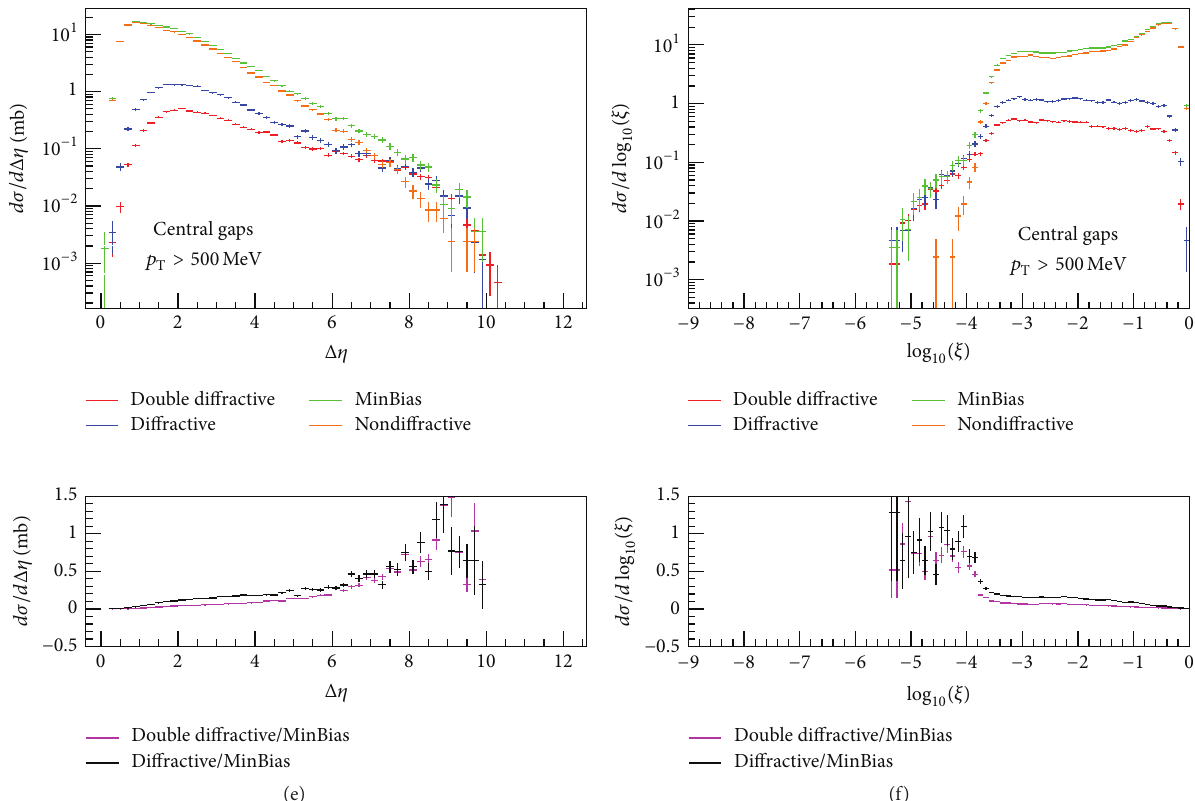
Figure 7: On the left side 𝑑𝜎/𝑑Δ𝜂 and on the right side 𝑑𝜎/𝑑 log 10 𝜉 for different event classes. Gap is defined as central gap and no 𝑝 T cut (a, b), 𝑝 T > 200 MeV (c, d), and 𝑝 T > 500 MeV (e, f) cuts are applied for all final state particles in |𝜂| < 5.2 .